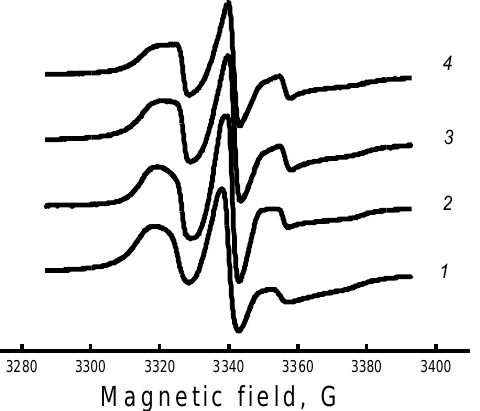
Figure 6. EPR spectra of the TEMPO nitroxide radical for PHB samples with hemin concentration: 1 — 0%, 2 — 1%, 3 — 3%, 4 — 5%.